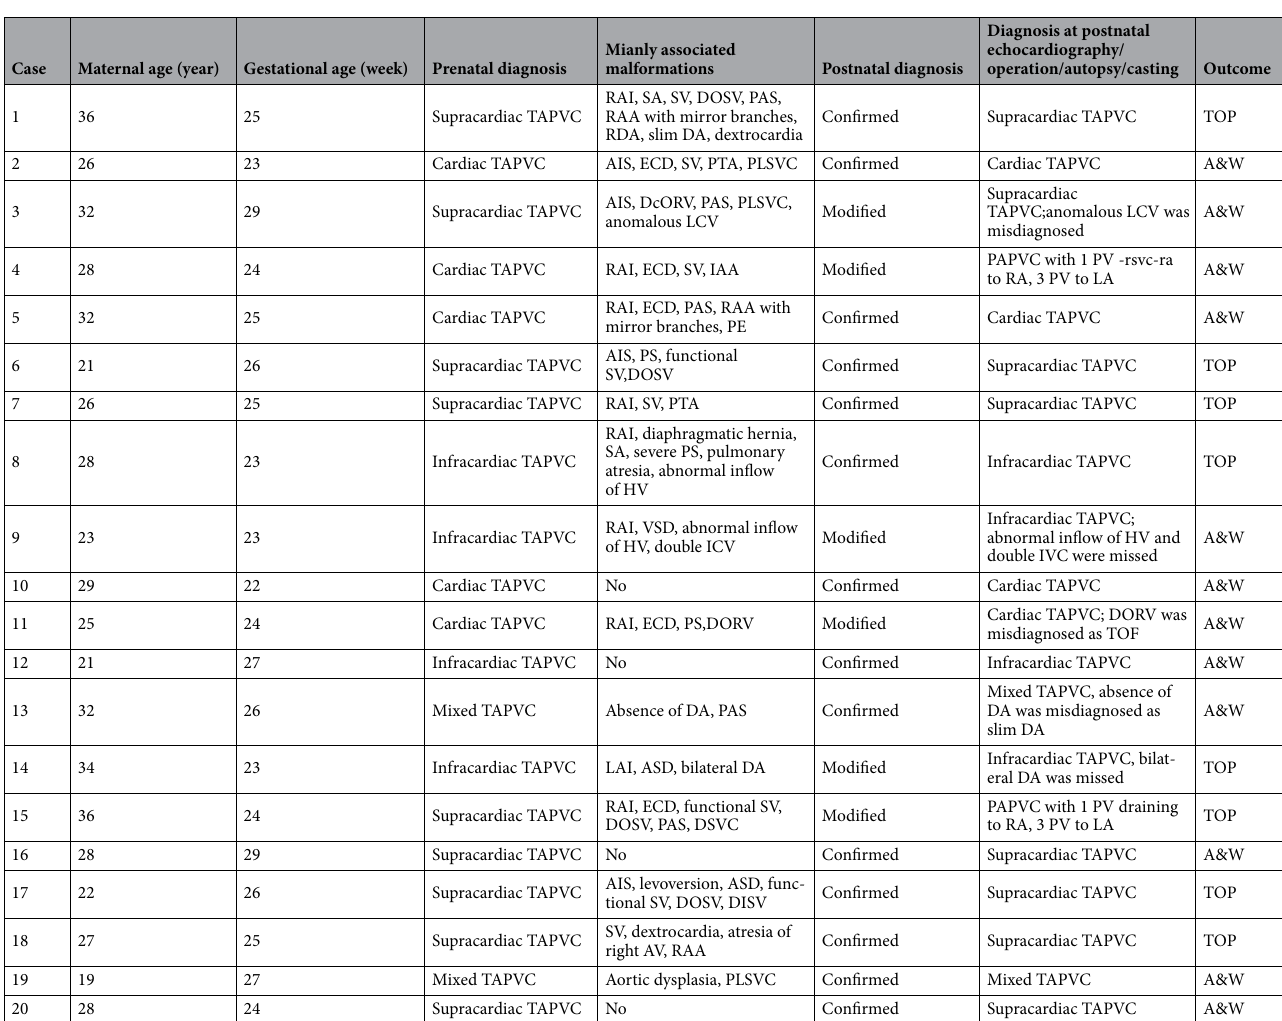
Table 1. Prenatal diagnosis, postnatal characteristics, and outcome of 20 cases with prenatally diagnosed TAPVC. RAI right atrial isomerism syndrome, SA single atrium, SV single ventricle, DOSV double-outlet single ventricle, PAS pulmonary artery stenosis, RAA right aortic arch, RDA right descending aorta, TOP termination of pregnancy, HV hepatic vein, AIS atrial isomerism syndrome, ECD endocardial cushion defect, PTA persistent truncus arteriosus, PLSVC persistent left superior vena cava, DORV , double outlet right ventricle, LCV left cephalopobrachial vein, IAA interrupted aortic arch, PE pericardial effusion, HV hepatic vein, VSD ventricular septal defect, IVC Inferior vena cava, DSVC double superior vena cave, DISV double inlet single ventricle, AV atrioventricular valve, A&W alive when